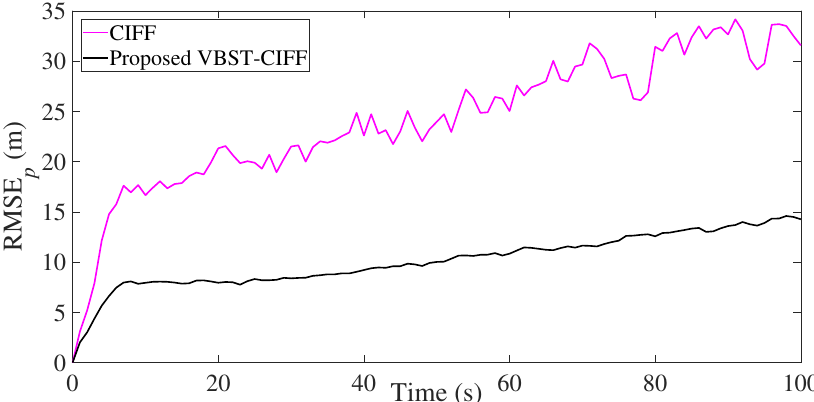
Figure 9. Position RMSE of fusion in multi-sensor target